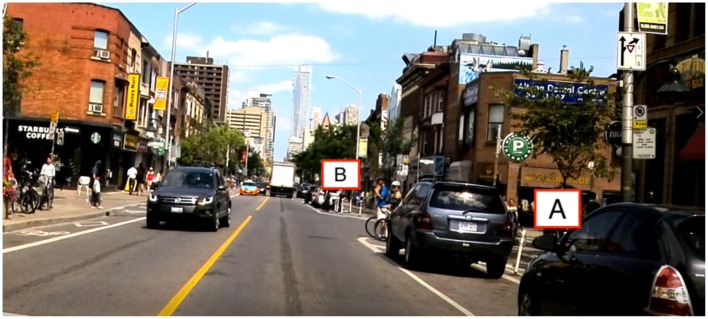
Fixation on point B allows more of the road ahead to be maintained in the driver's central vision than fixation on point A.